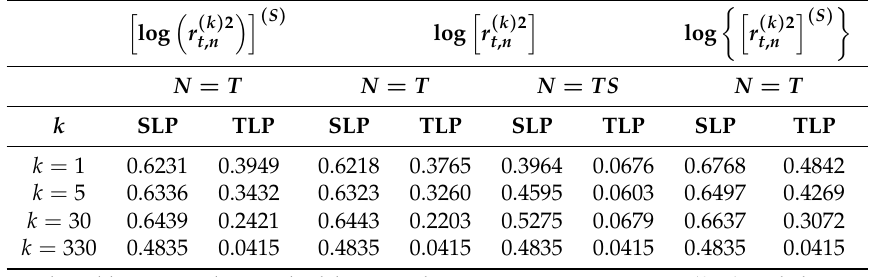
Table 2. Long-memory parameter estimates with high-frequency S&P 500 futures